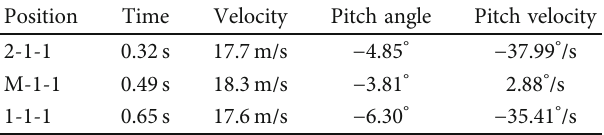
Table 4: The results from di ff erent sliding distance. Position Time Velocity Pitch angle Pitch